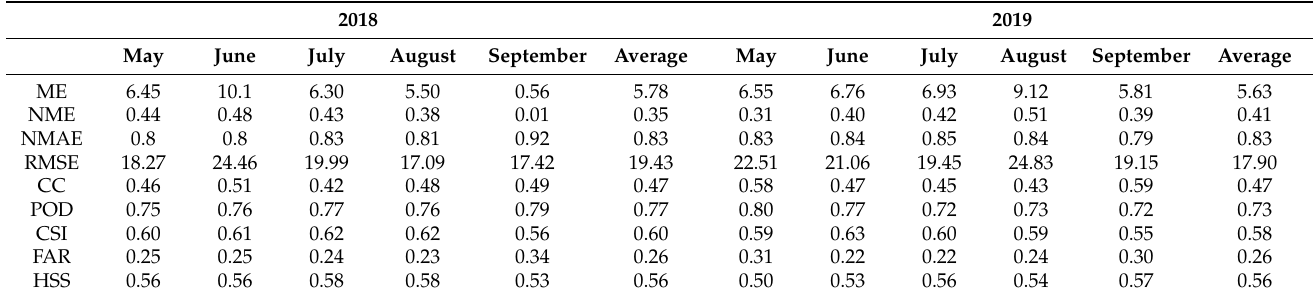
Table 4. Evaluation results of daily rainfall accumulations (CONUS-east *).